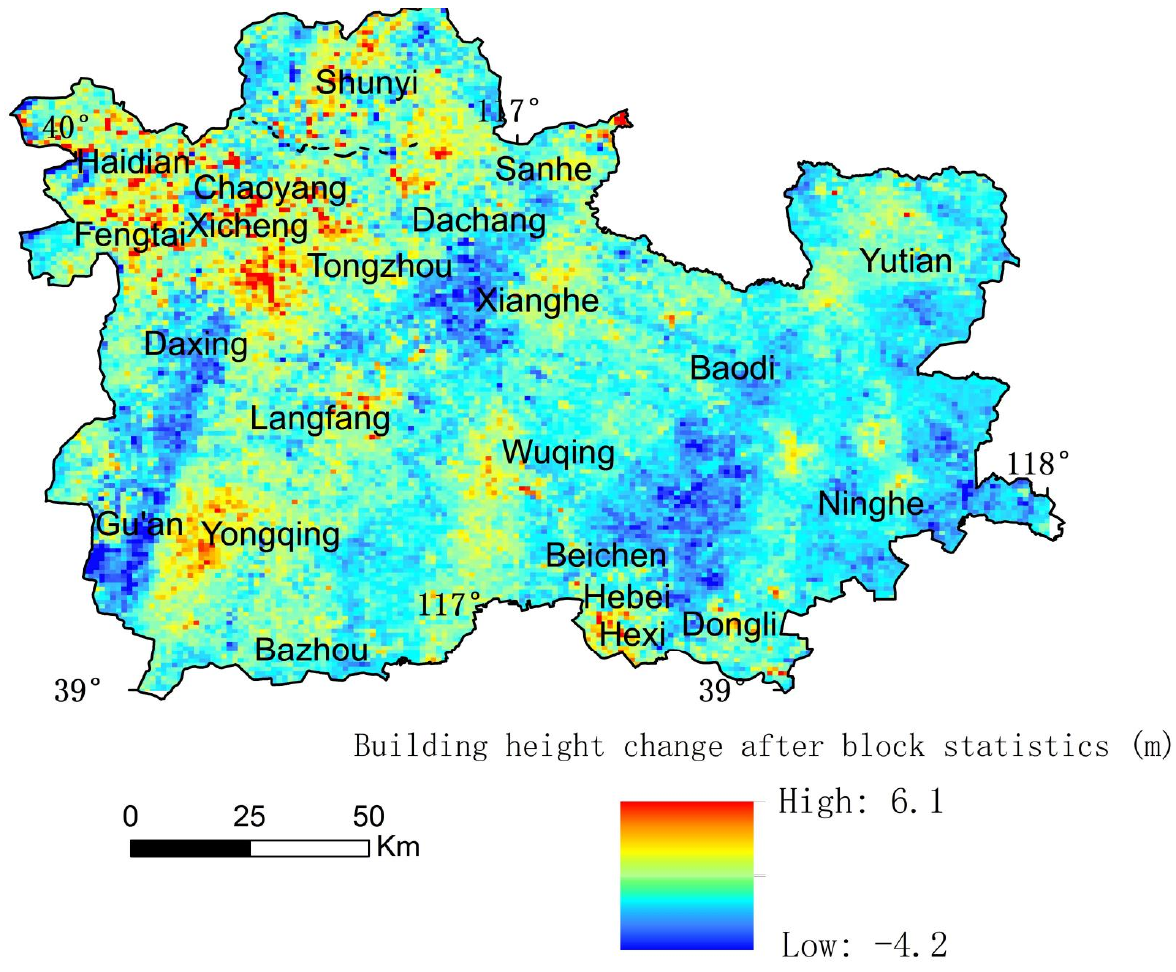
Figure 9. The result of building expansion by continuous block statistics.